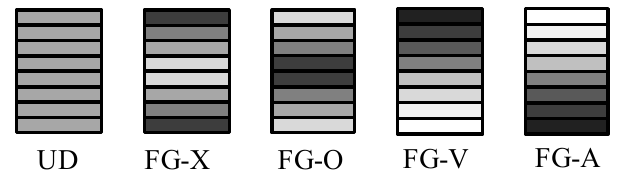
Figure 2. Schematic diagrams of the GPL distribution patterns.